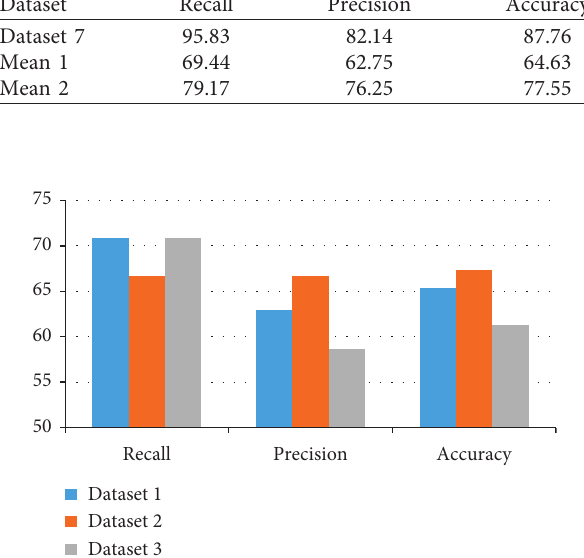
Figure 1: Comparison of judgment results among Datasets 1–3.